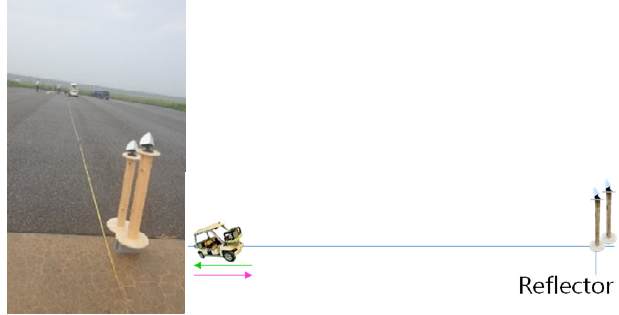
Figure 21. Test setup for measuring the range resolution.